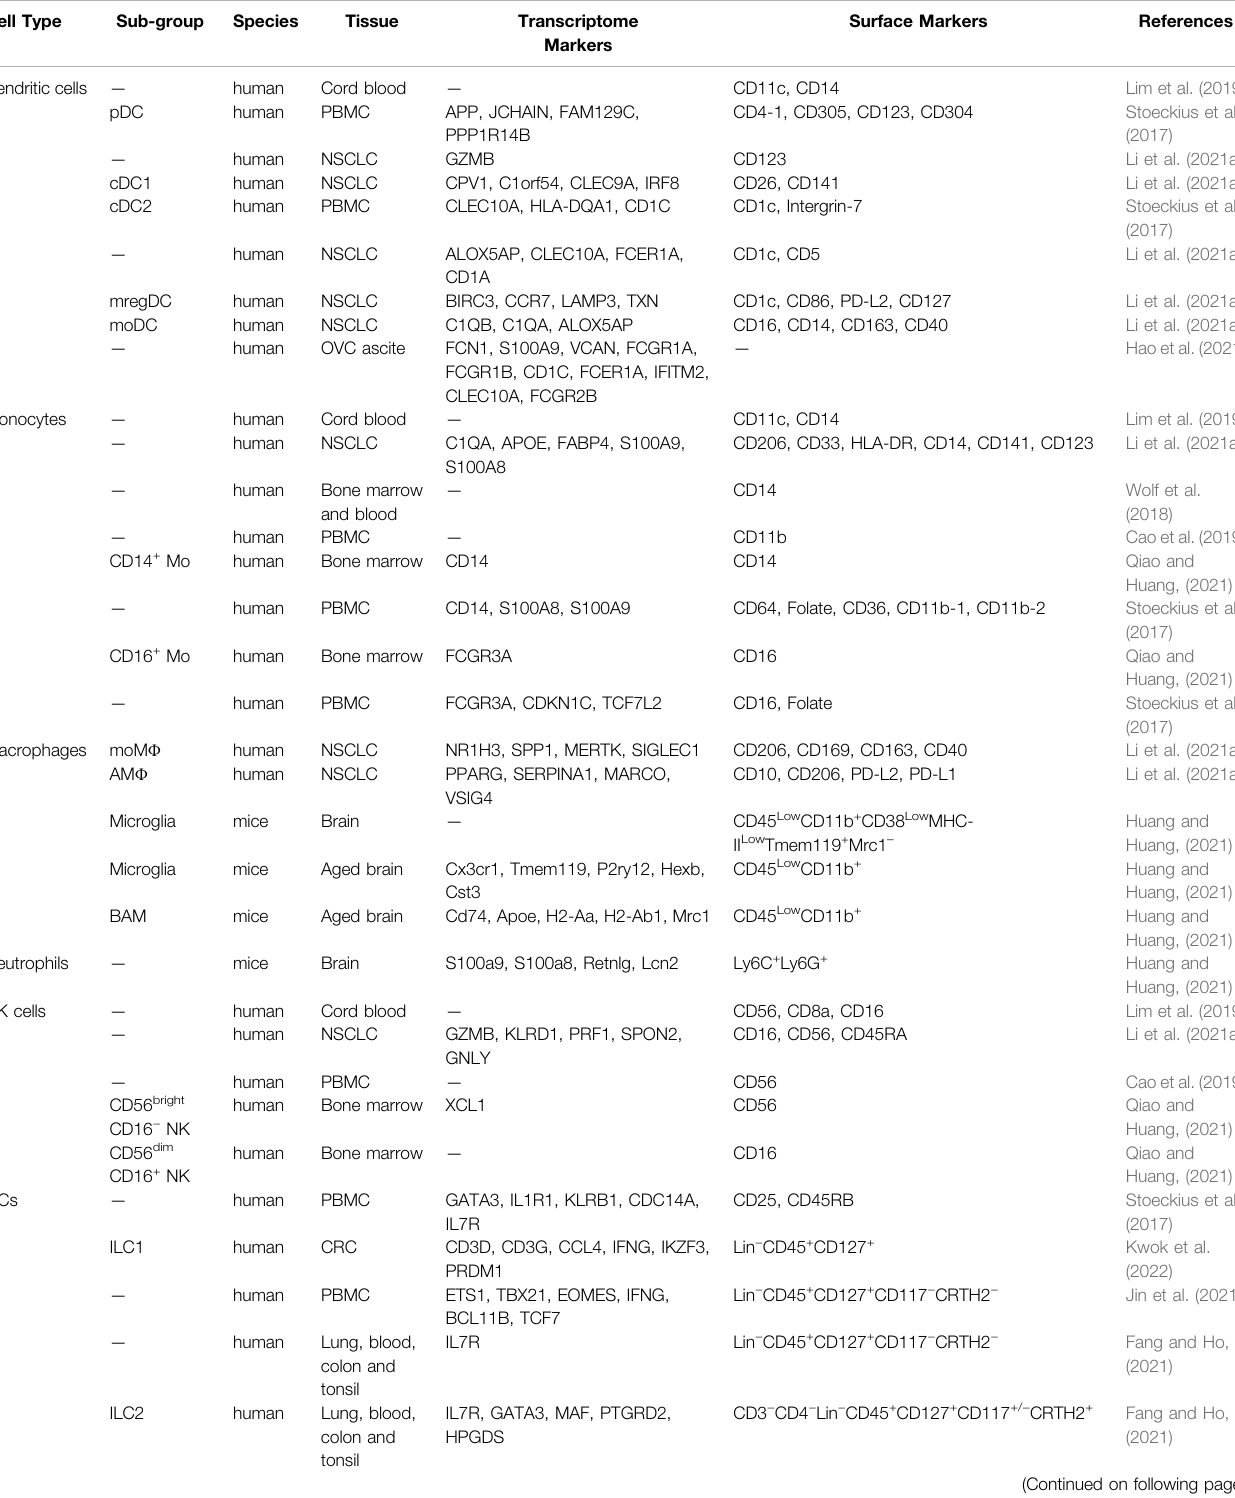
TABLE2| PhenotypicmarkersofinnateimmunecellsusingCITE-seqorscRNA-seq.pDC,plasmacytoidDC.cDC1,type1conventionalDC.cDC2,type2conventionalDC. mregDC, mature DC expressing regulatory molecules. moM Φ , monocyte-derived macrophage. AM Φ , alveolar macrophage (tissue-resident macrophage). NSCLC, non-small cell lung cancer. PBMC, peripheral blood mononuclear cells. OVC, ovarian cancer. BAM, border-associated macrophages. CRC, colorectal cancer. Transcriptome markers are mainly derived from clustering results, while surface markers are collected based on antibody-derived tags (ADT) by CITE-seq or FACS